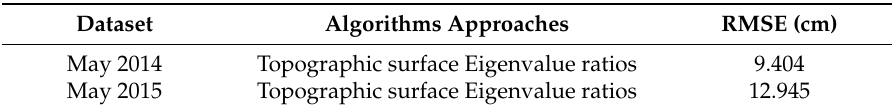
Table 5. The RMSE between the ground truth and the extracted landslide scarp using the different approaches for datasets of the study landslide, May 2014 and May 2015.